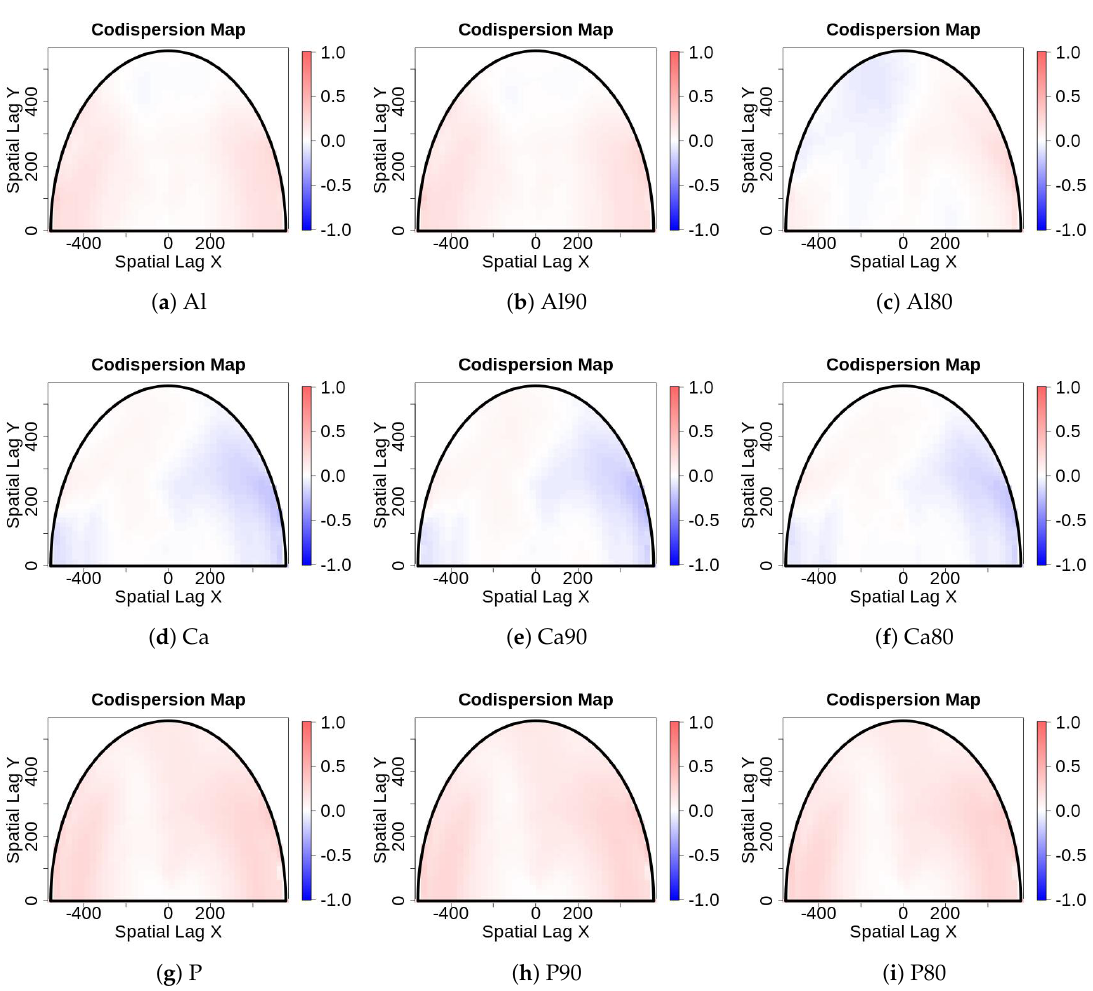
Figure 11. Codispersion between species A. blackiana and soil chemistry variables; (Al ( a – c ); Ca ( d – f ) and P ( g – i )). Soil data were unthinned ( a , d , g ); thinned 10% ( b , e , h ); or thinned 20% ( c , f , i